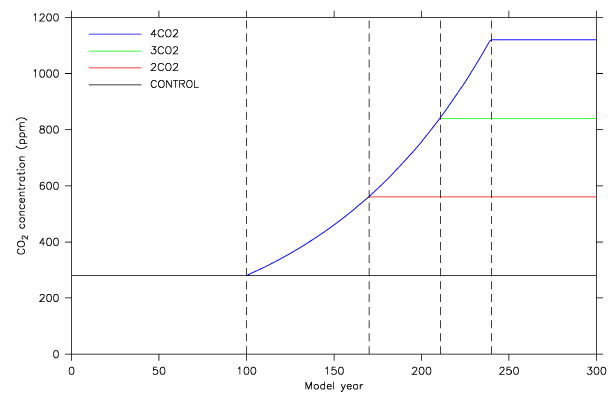
Fig. 18. The atmospheric carbon dioxide concentration applied dur- ing experiments CONTROL (black), 2CO2 (red), 3CO2 (green) and 4CO2 (blue). Vertical dashed lines indicate model years 100, 170, 211 and